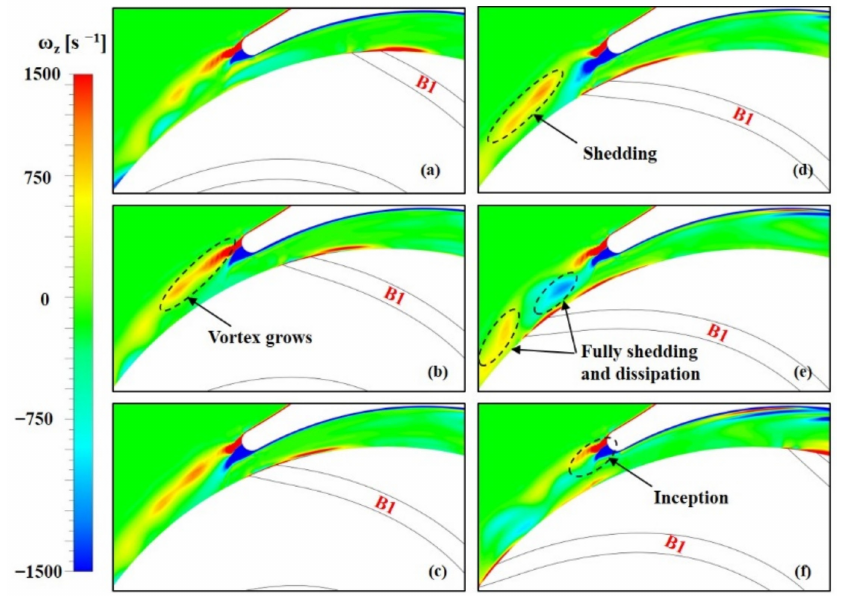
Figure 12. Z-direction vorticity at volute tongue leading edge in the 1/6 impeller rotating periods